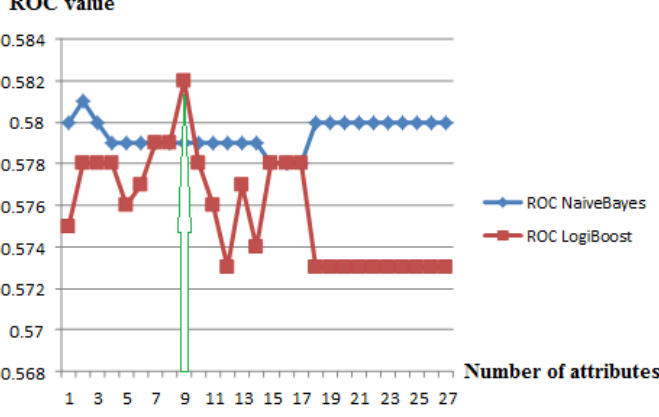
Figure 3. Determining maximum ROC value for a minimum number of attributes .